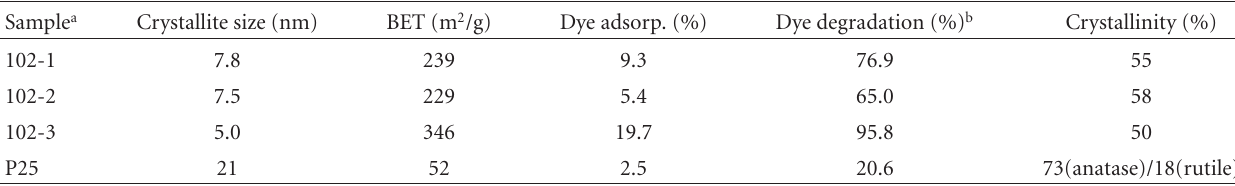
Table 1: Summary of physicochemical properties of TiO 2 .